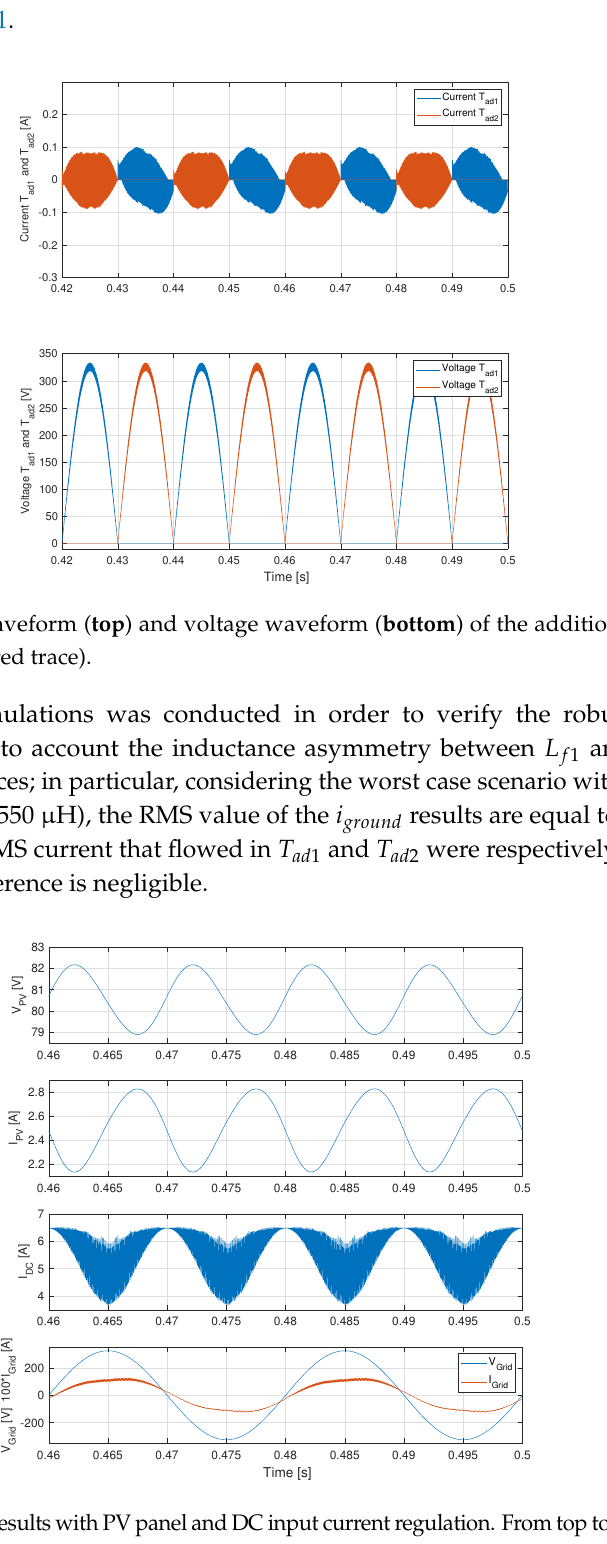
Figure 15. Simulation results with PV panel and DC input current regulation. From top to bottom: PV panel voltage; PV panel current; current on L DC ; grid voltage (blue) and output current (red)